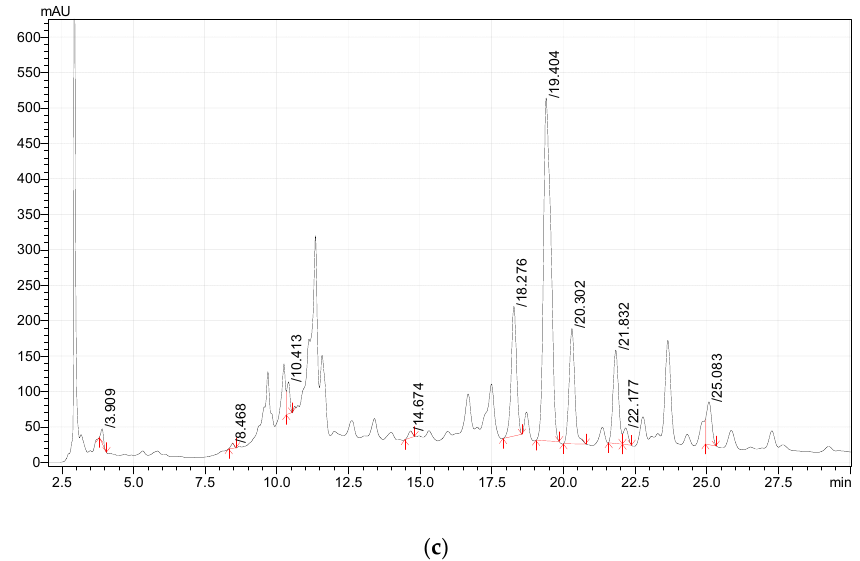
Figure 1. RP-HPLC-UV chromatograms acquired at 254 nm of ethyl acetate ( a ), methanol ( b ), and aqueous ethanolic extracts ( c ) of F. ulmaria (leaves).